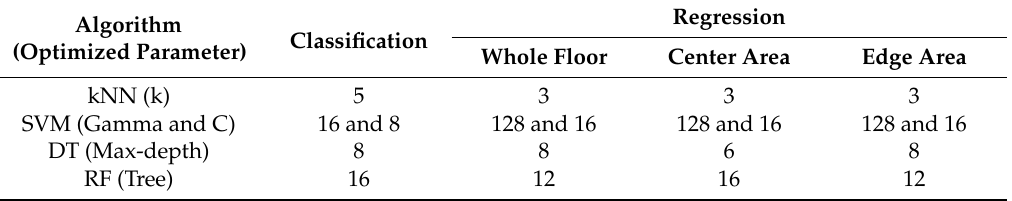
Table 2. Optimal parameters.